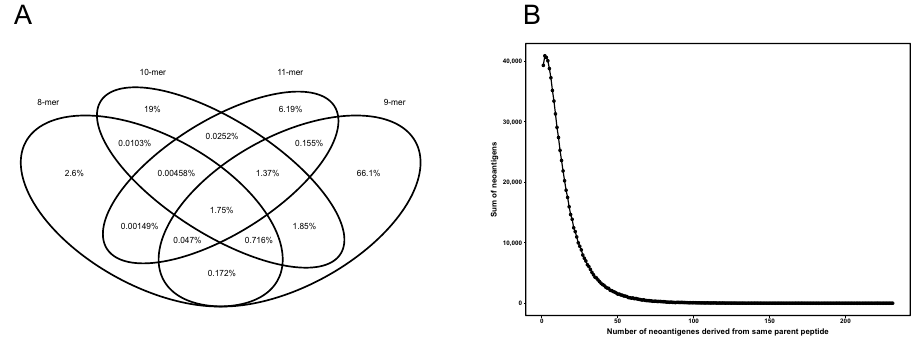
Figure 3. The overlap between 8-mers to 11-mers and distribution of neoepitopes per variant. Venn diagram of the overlap between the predicted peptide binders of lengths 8–11. 9-mers were the most common among neoepitopes. ( A ) Variant that gave rise to a neoepitope of a certain length very seldom formed neoepitope even when just one residue is added or deleted from the sequence. ( B ) The distribution of neoepitopes per variant peptide. The number of neoepitopes per variant varied widely, from 1 to 231. Most variants yielded just one or a few neoepitopes. Only a small fraction of variants appeared in many